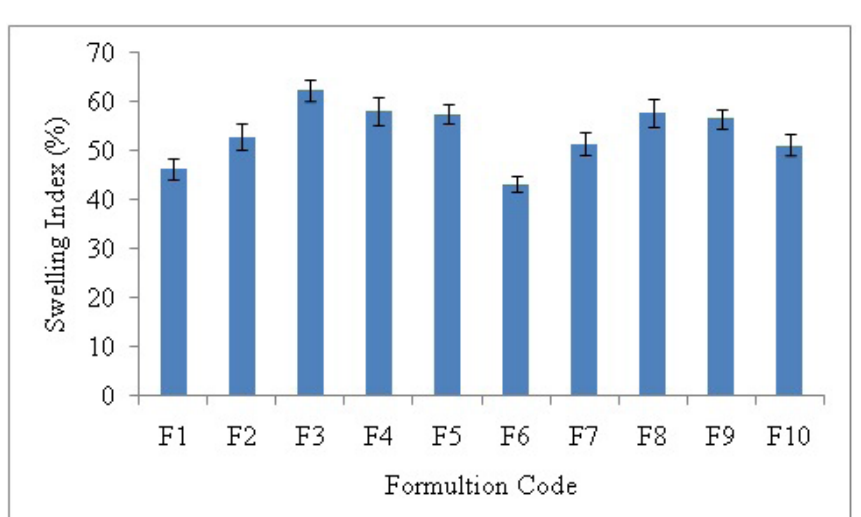
FIGURE 2 - Percentage of swelling of developed buccal tablets.